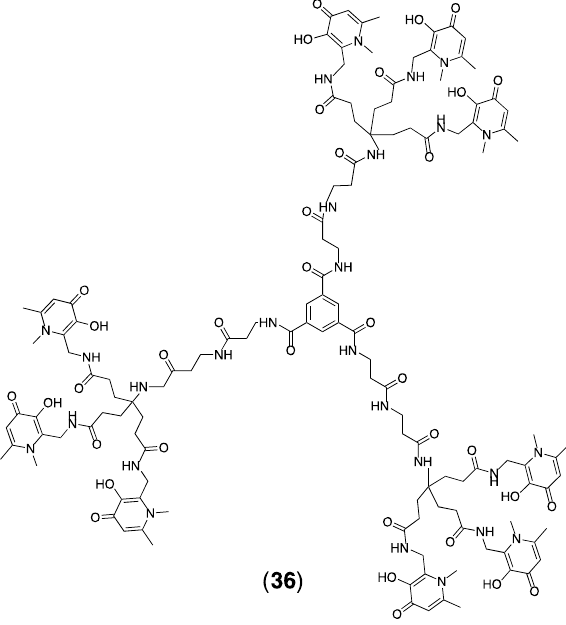
Figure 7. Dendritic 3,4-HPs such as ( 36 ) can coordinate multiple Fe 3+ ions.